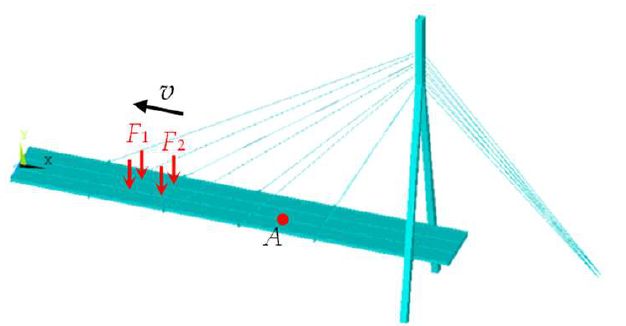
Figure 7. The FEM of the cable-stayed bridge under vehicle loads [18].